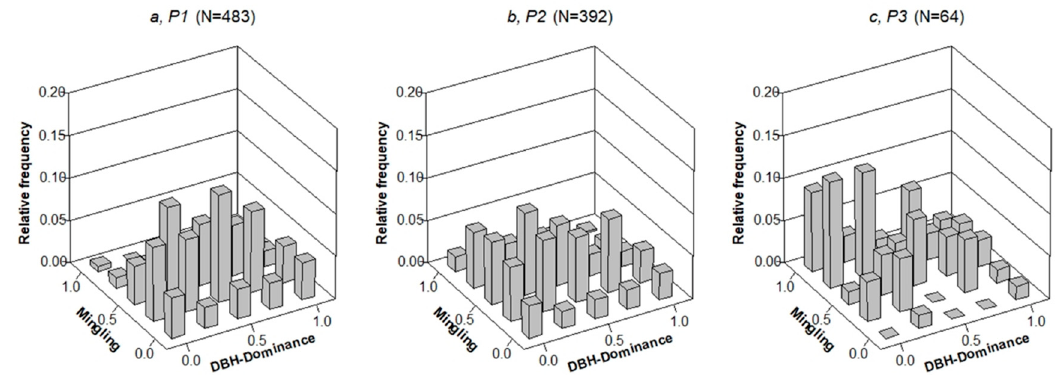
Figure 4. Bivariate distributions of mingling versus diameter at breast height (DBH) dominance on three sample plots P1 ( a ), P2 ( b ) and P3 ( c ). N: number of S. macrophyllus individuals.